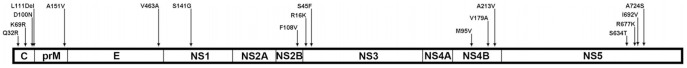
Tertiary structure of NS3 protease.The crystal structure of the West Nile protease (PDB code 3e90) was taken as a template for homology modeling. (A) The tertiary structure of NS3/NS2B for the pathogenic strain Dalnegorsk. (B) The tertiary structure of NS3/NS2B for the Sfd strain Primorye-270. The arrows indicate the replacement of key amino acids. The active center is indicated by the rectangle and its amino acid residues are shown as red atoms.